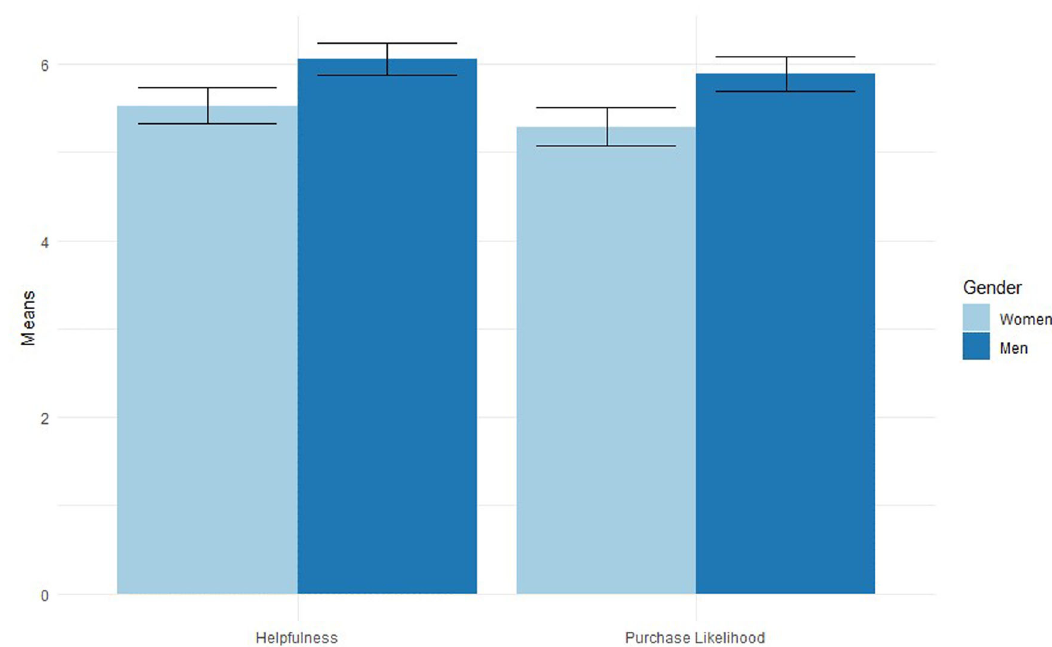
Fig. 2 Helpfulness and likelihood to purchase for online reviews contributed by women vs. men in study 1. Error bars represent